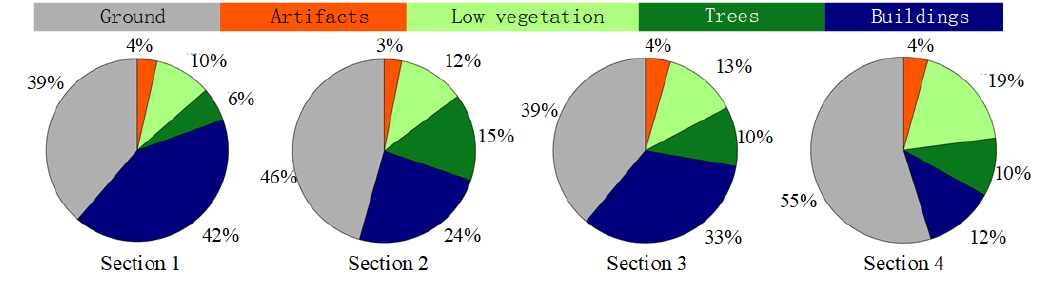
Figure 5. Percentage of labeled points in different sections.